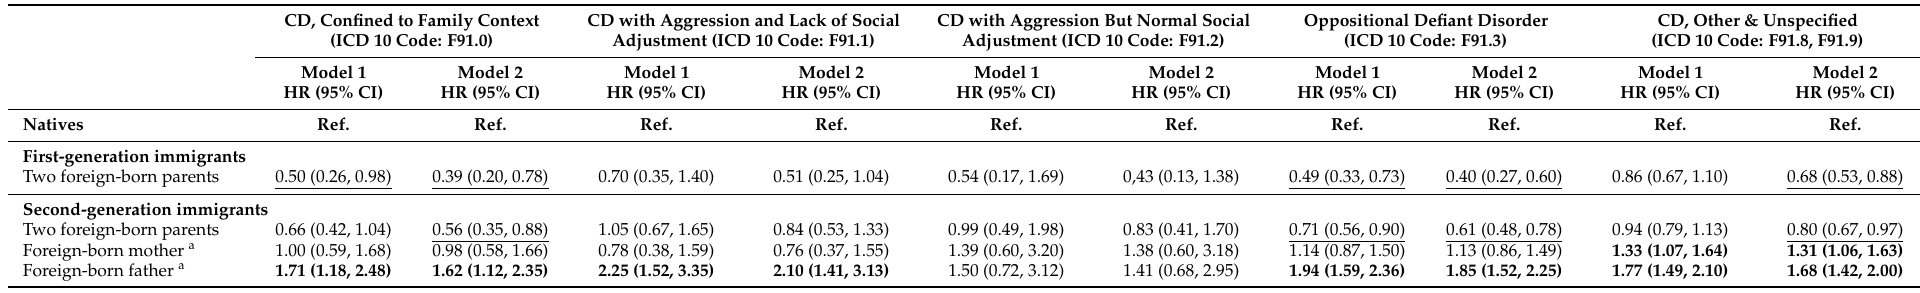
Table A3. Hazard Ratios of subtypes of conduct disorder in female participants with an immigrant background and 4–16 years at baseline compared with natives in Sweden, 2001–2015. CD, Confined to Family Context CD with Aggression and Lack of Social CD with Aggression But Normal Social Oppositional Defiant Disorder (ICD 10 Code: F91.0) Adjustment (ICD 10 Code: F91.1) Adjustment (ICD 10 Code: F91.2) (ICD 10 Code: F91.3)